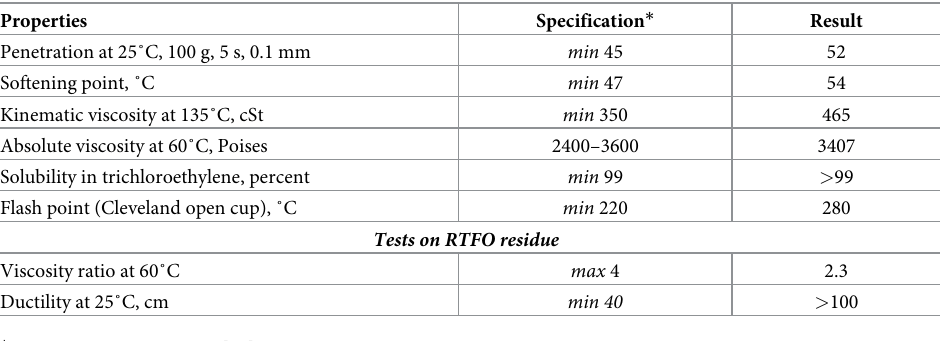
Table 1. Physical characteristics of base